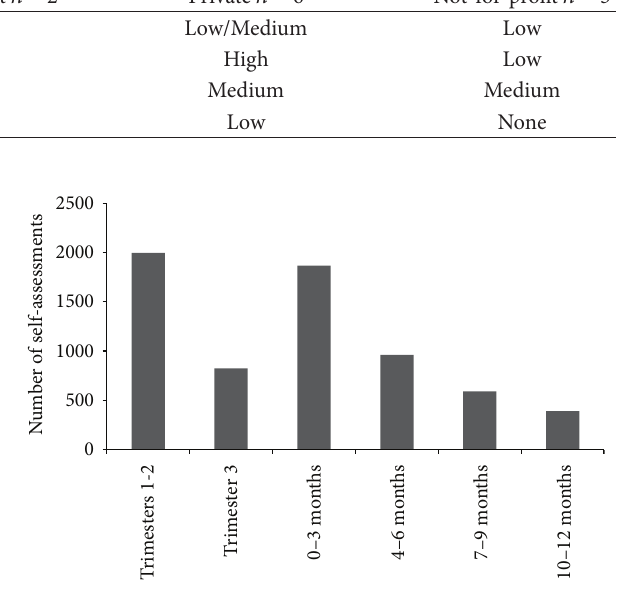
Table 2: Outcomes of gap analysis study showing levels of information provided by types of websites most frequently used by parents. Criteria for assessment